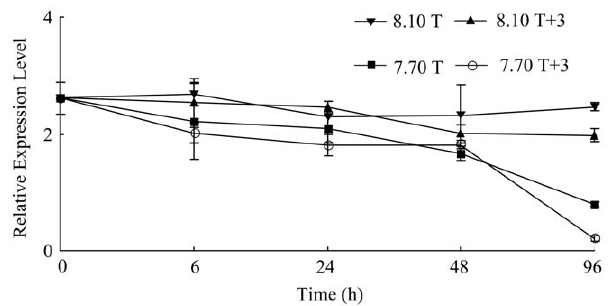
Figure 4. Real-time PCR analysis of expression of she-7-F10 in response to elevated temperature and declined pH.